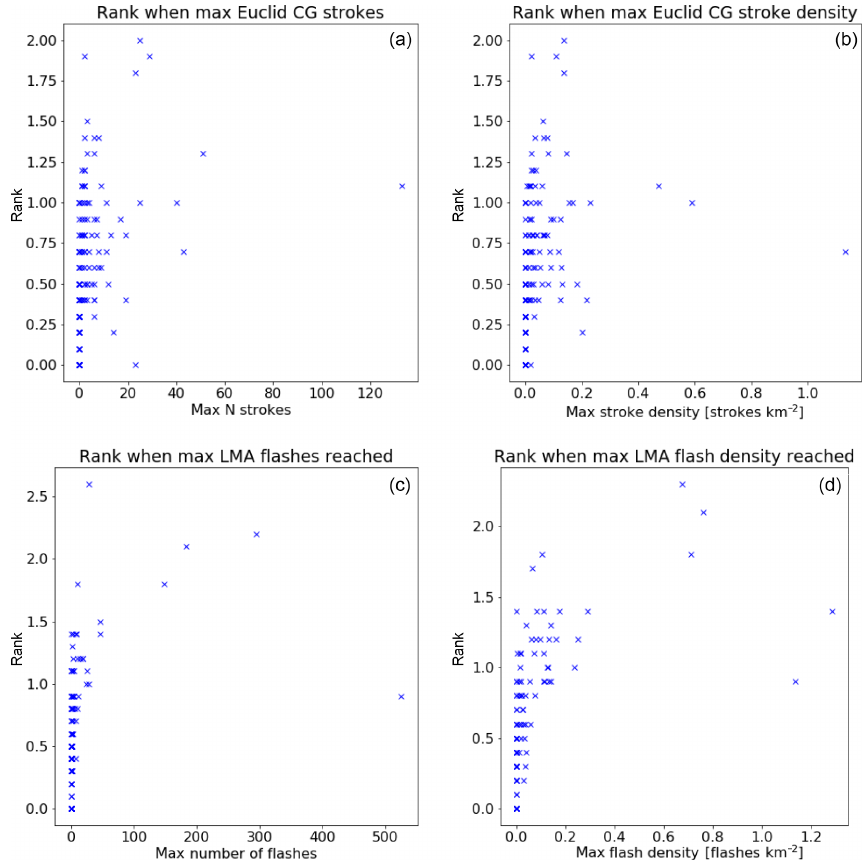
Figure 7. Scatter plot of (a) cell rank when the first maximum number of CG strokes detected by the EUCLID network is achieved. (b) Same as (a) , but for stroke density. (c) Same as (a) , but for LMA-detected flashes. (d) Same as (b) , but for LMA-detected